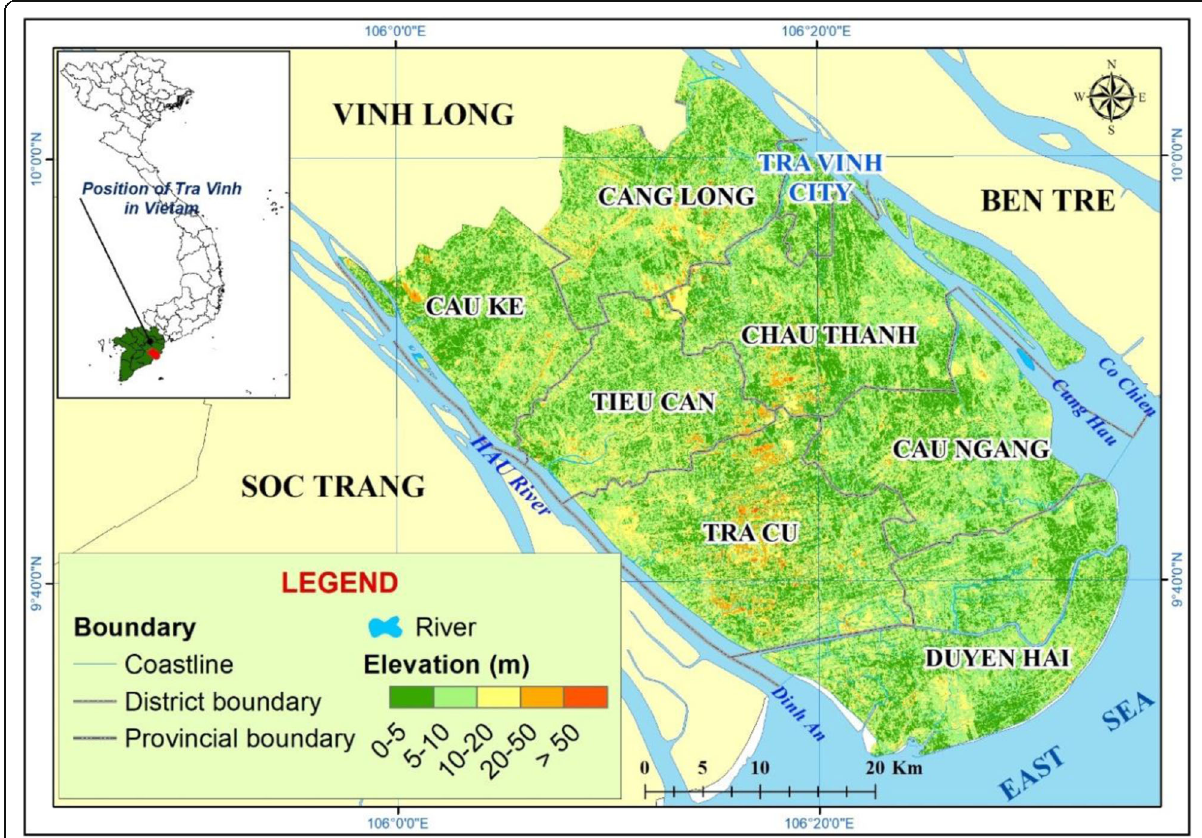
Fig. 1 Geographical location of Tra Vinh Province in the Mekong Delta, Vietnam, and DEM of Tra Vinh Province was built from terrain data with scale of 1/5000 (Source: Vietnam Department of Surveying and Mapping,